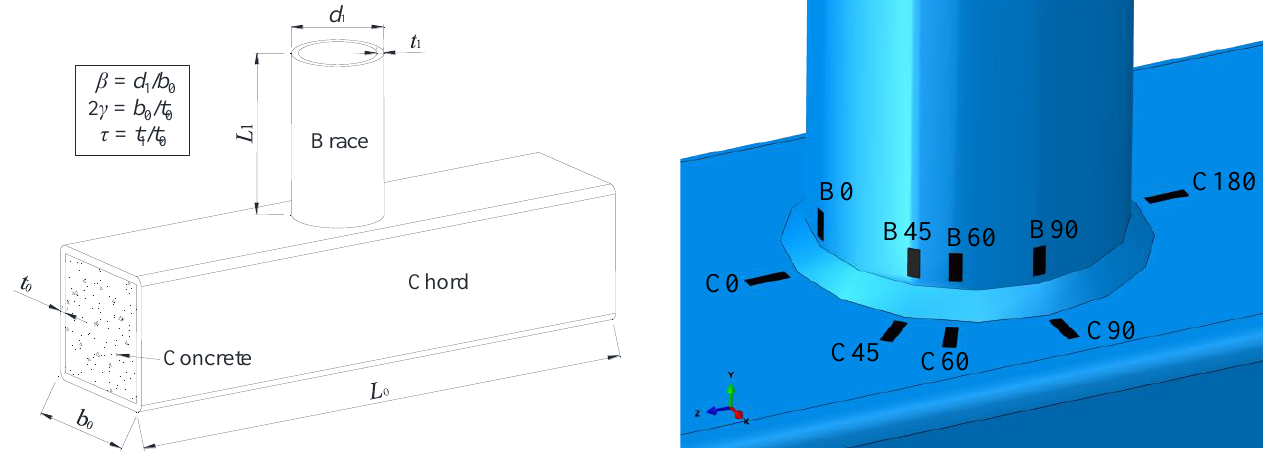
Figure 4: Schematic diagram of CHS-CFSHS T-joint. Figure 5: Calculated SCF